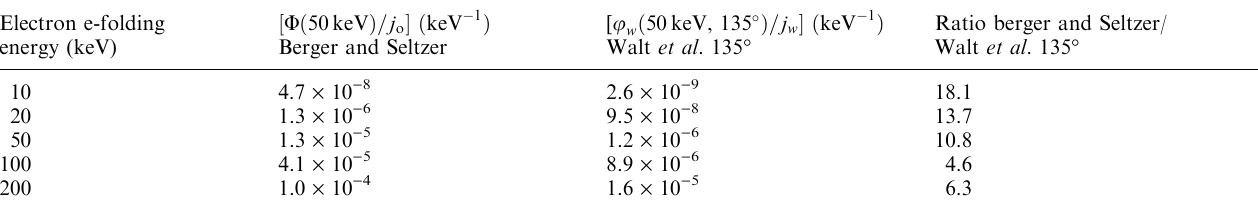
Table 1. The X-ray fluxes at 50 keV normalized to unit-directional incident integral electron fluxes. (cid:137) (cid:85) (cid:133) 50keV (cid:134) = j o (cid:138) are from the work of Berger and Seltzer and (cid:137) (cid:117) (cid:133) 50keV ; 135 (cid:14) (cid:134) = j w (cid:138) are from the work of w Walt et al. The column to the right gives the ratio, i.e. the reduction Electron e-folding (cid:137) (cid:85) (cid:133) 50keV (cid:134) = j o (cid:138) (cid:133) keV (cid:255) 1 (cid:134) energy (keV) Berger and Seltzer